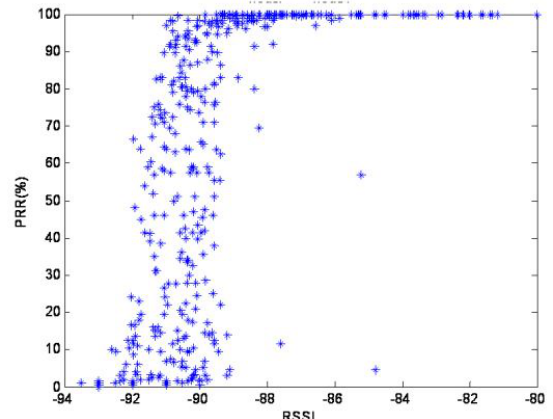
Figure 5. Packet Reception Ratio (PRR) vs. Received Signal Strength Indicator (RSSI) Signal CC2420 chip Baccour et al.